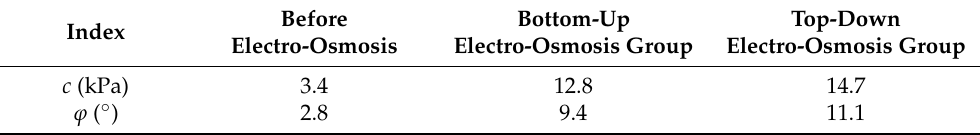
Table 3. Comparison of soil shear strength before and after electro-osmosis.